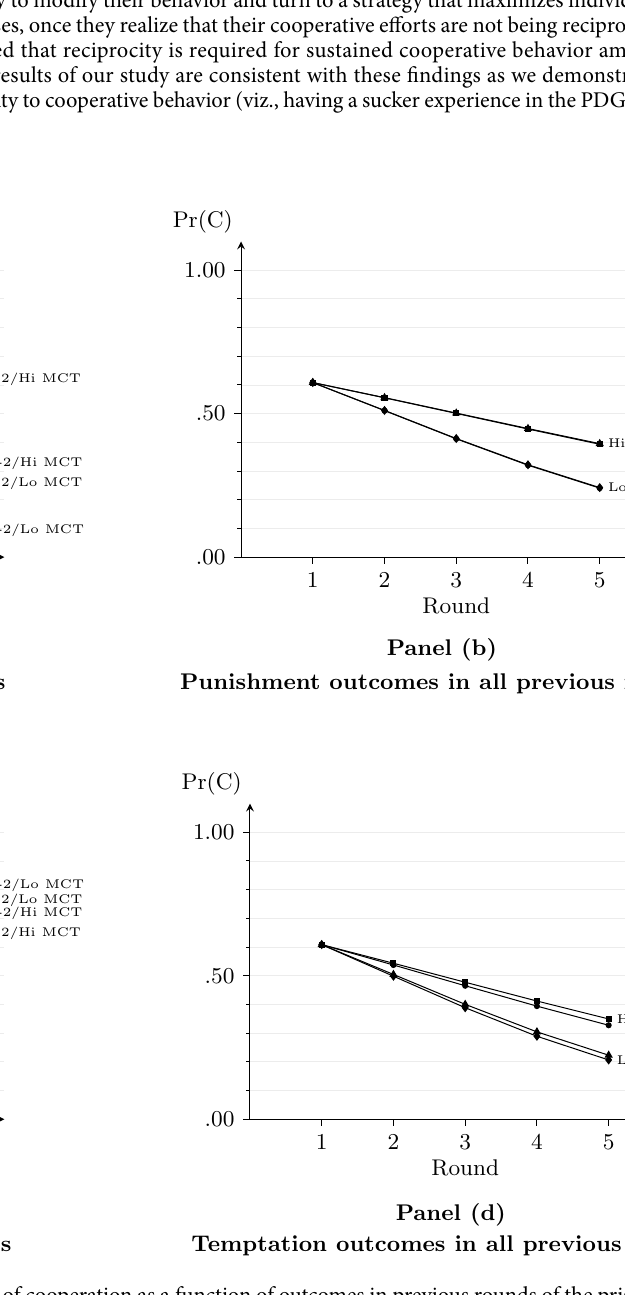
Figure 4. Predicted probability of cooperation as a function of outcomes in previous rounds of the prisoner’s dilemma game and high versus low scores on the DIT-2 and